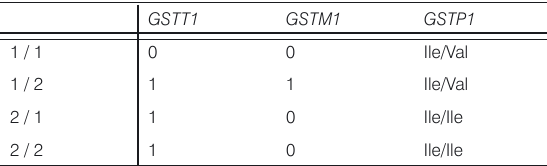
Table 3. GST metabolizing enzyme polymorphism